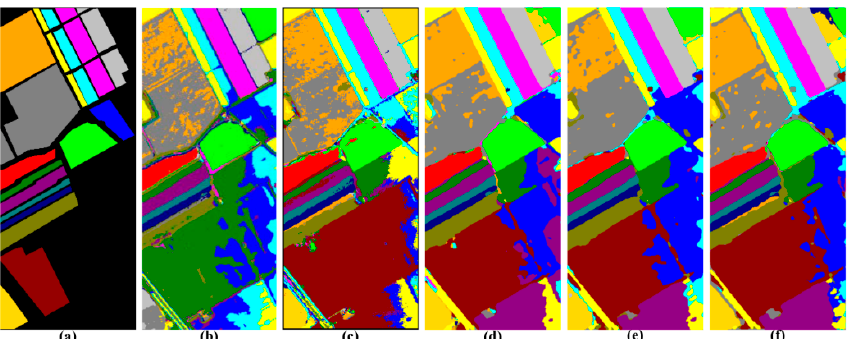
Ground-truth map; ( b ) SAE-LR; ( c ) CNN; ( d ) SSRN; ( e ) FDSSC; and ( f ) AUSSC. Remote Sens. 2019 , 11 , x FOR PEER REVIEW